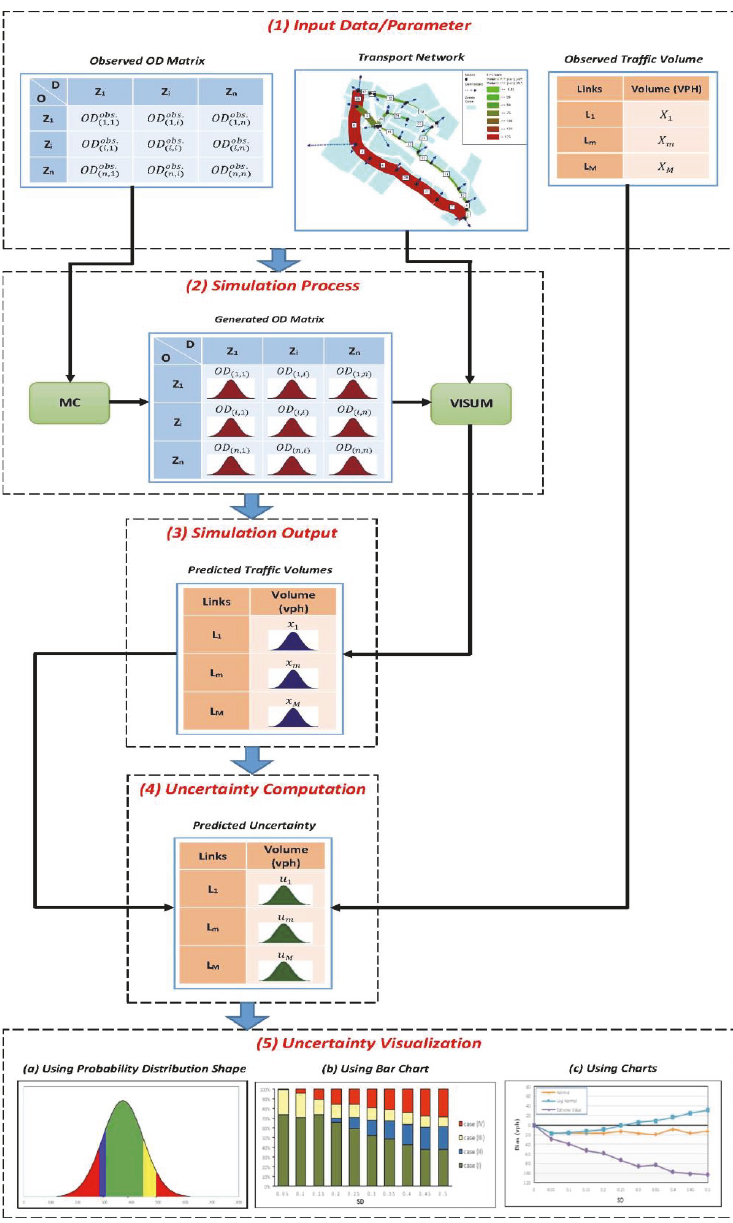
Figure 1: The methodology of uncertainty